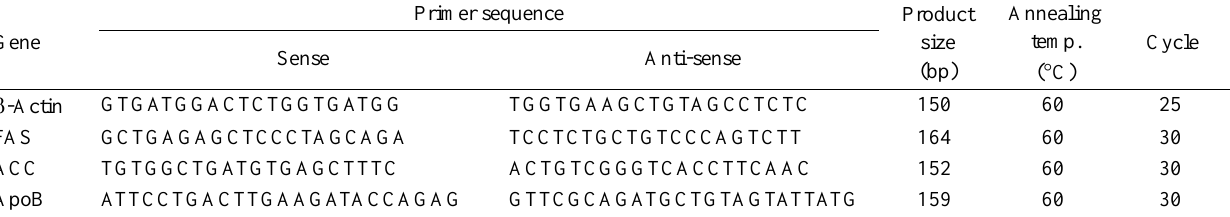
Figure 1. Standard for liver color score. The color of normal liver was scored 1 and the color score from 2 to 5 (from dark red to light yellowish red) was judged by three Table 2. Primer sequences of  -actin, FAS, ACC, and ApoB